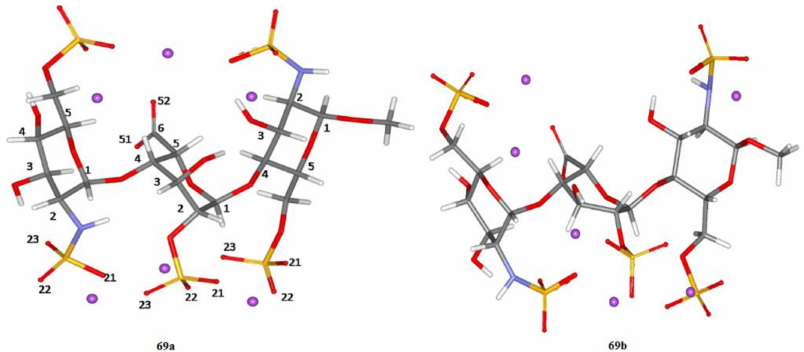
Figure 34. Structure of heparin trisaccharide A. The two forms, 69a and 69b , correspond to the different conformations of the IdoA2S residue (central residue). In 69a , the IdoA2S residue is in the 1 C 2 S 4 conformation; in 69b , the IdoA2S residue is in the 0 conformation. Both GlcN,6S residues are in the 4 C 1 conformation. Violet dots represent sodium ions. Solvent (water) molecules are not shown for clarity. Reproduced from Hricov í ni and coauthors [145] with the permission of the American Chemical Society.